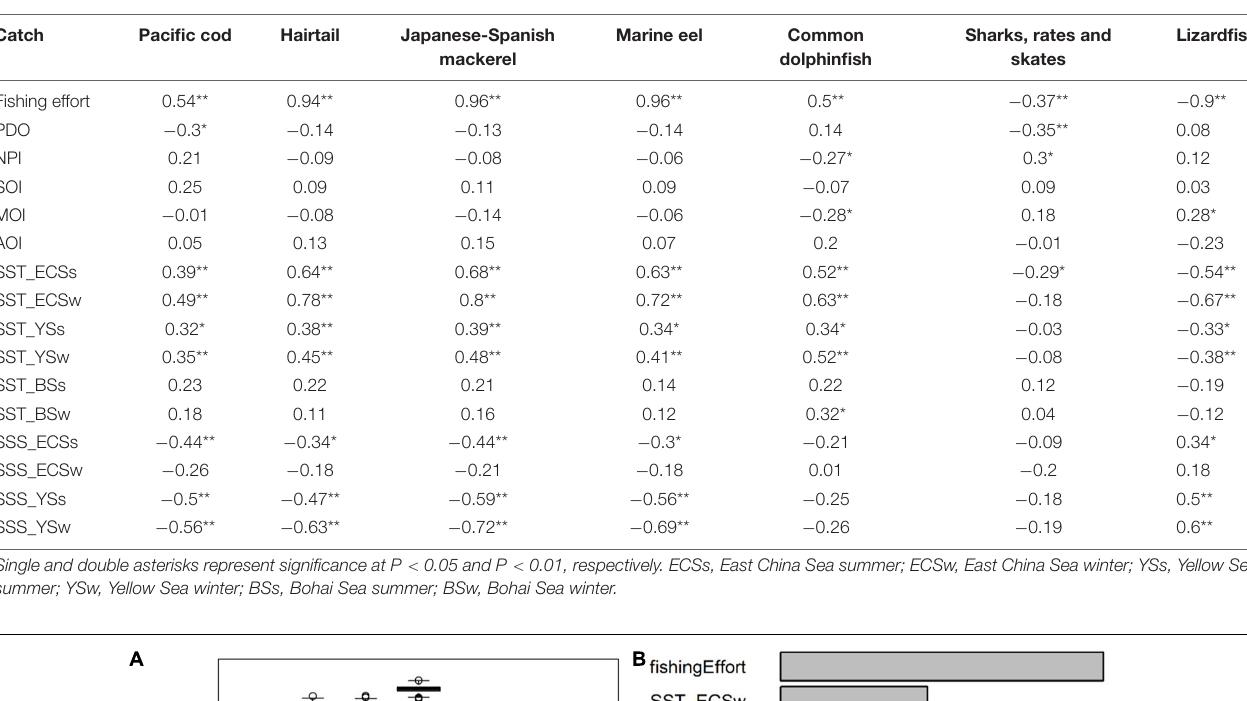
TABLE 2 | Correlation analysis between catch of Chinese piscivorous fish and climatic/SST indices. Catch Pacific cod Hairtail Japanese-Spanish